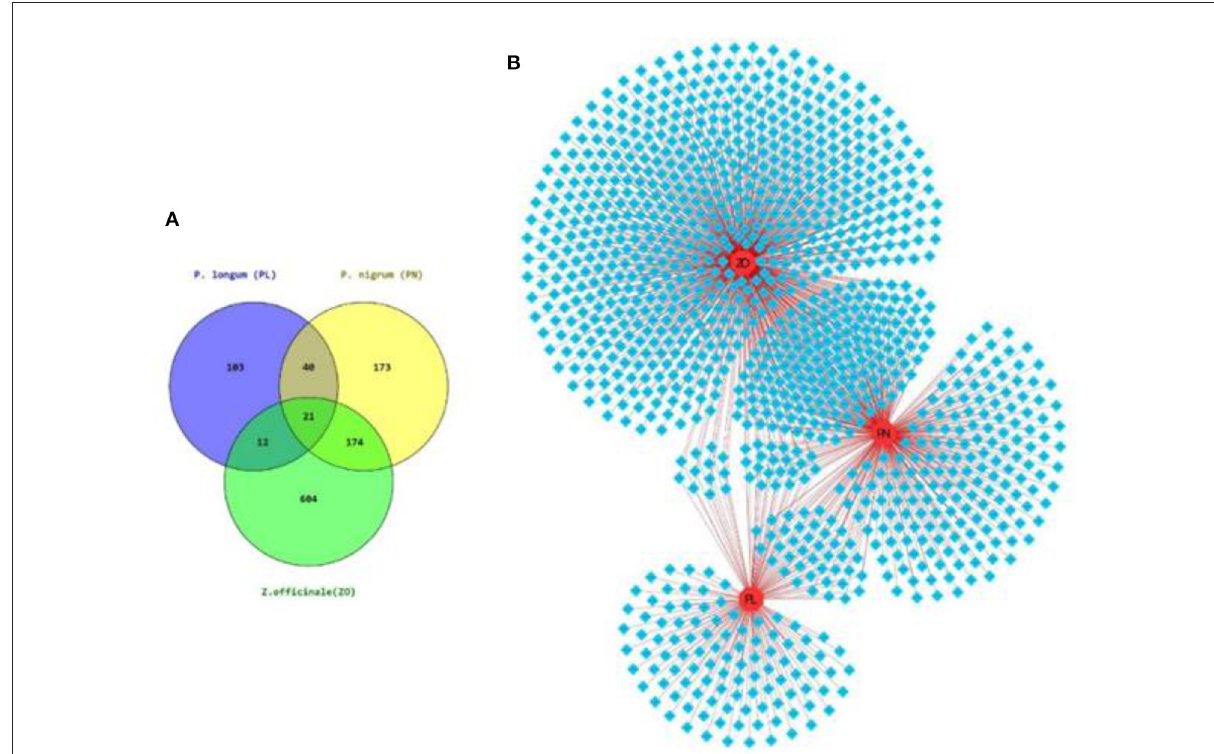
FIGURE3 Phytochemical composition of TC . (A) Venn diagram showing the herb-wise distribution of 1,127 PCs associated with the tri-herbal formulation of TC . (B) Herb-Phytochemical Network of size 1,130 node 1,395 edges, where 1,127 PCs are shown in blue diamonds and herbs in red circular